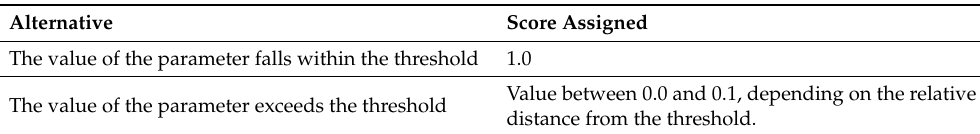
Table 5. Scores s assigned to each alternative.